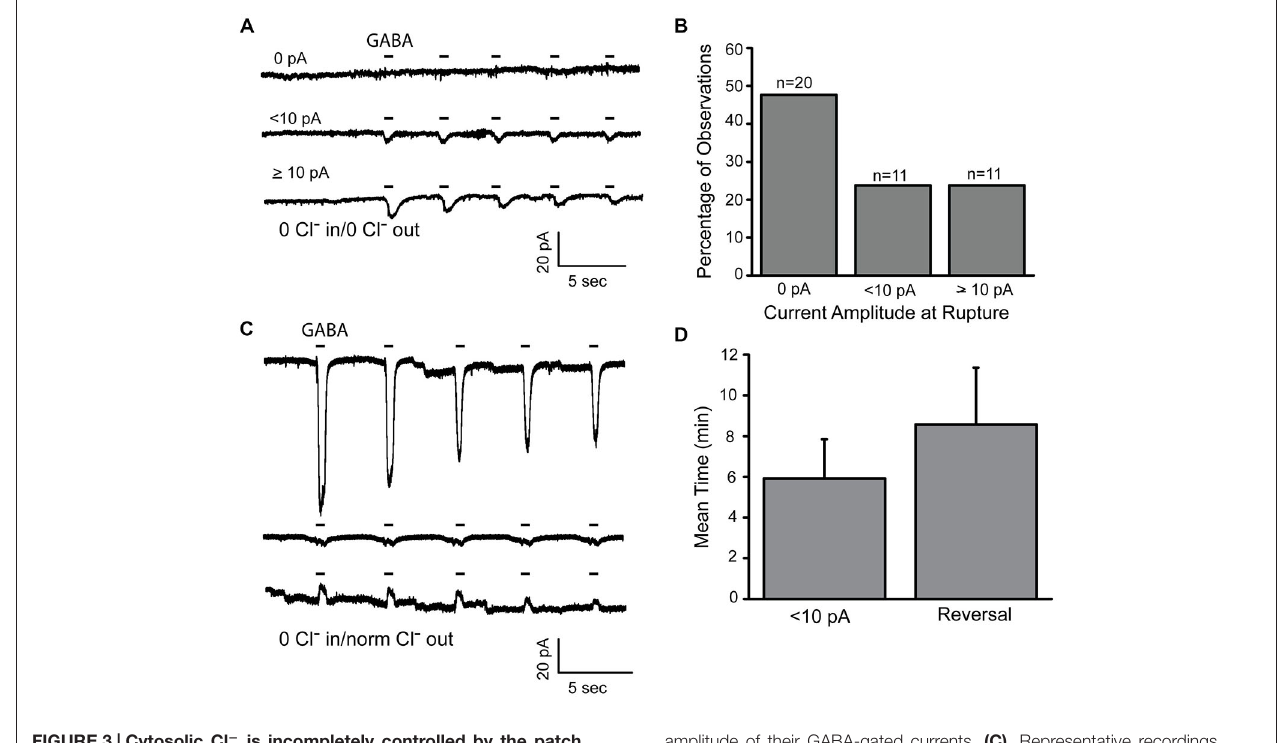
FIGURE 3 | Cytosolic Cl − is incompletely controlled by the patch pipet. (A) , Representative recordings from three different amacrine cells made within 5 s of membrane rupture. Cells were recorded with zero Cl − pipet and extracellular solutions and were held at − 70 mv. GABA (20 µ M) was applied in 400 ms pulses. (B) , Forty-two cells recorded under the conditions in (A) are categorized by the initial